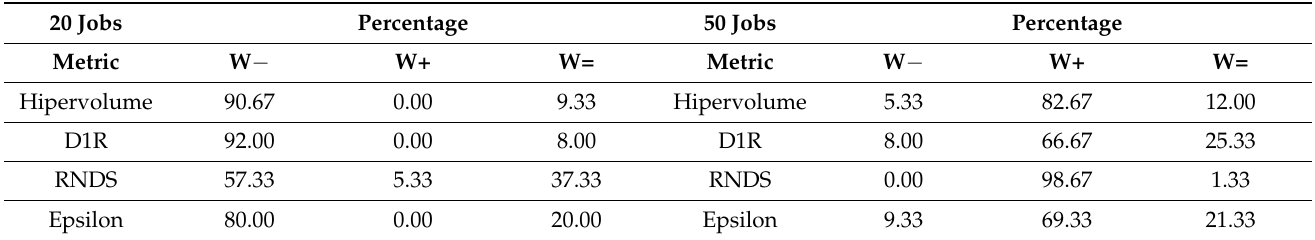
Table 2. Wilcoxon test results on metaheuristics for problems with 20 and 50 jobs.